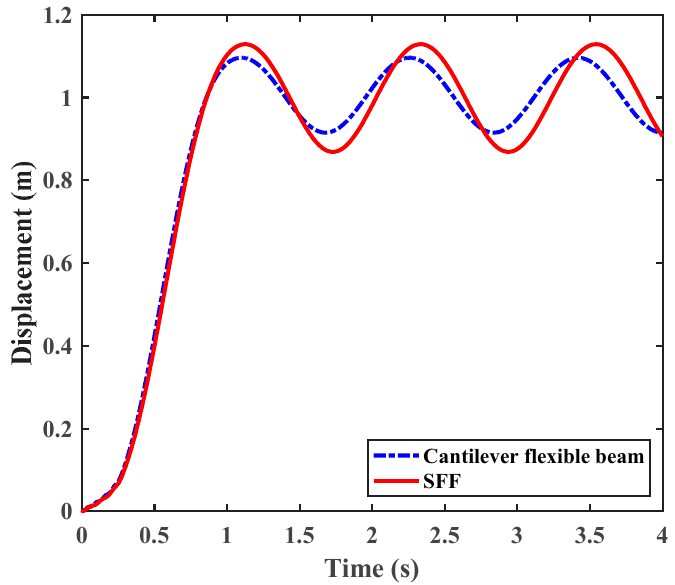
Figure 6. Comparison of tip payload displacements from two simulation models.